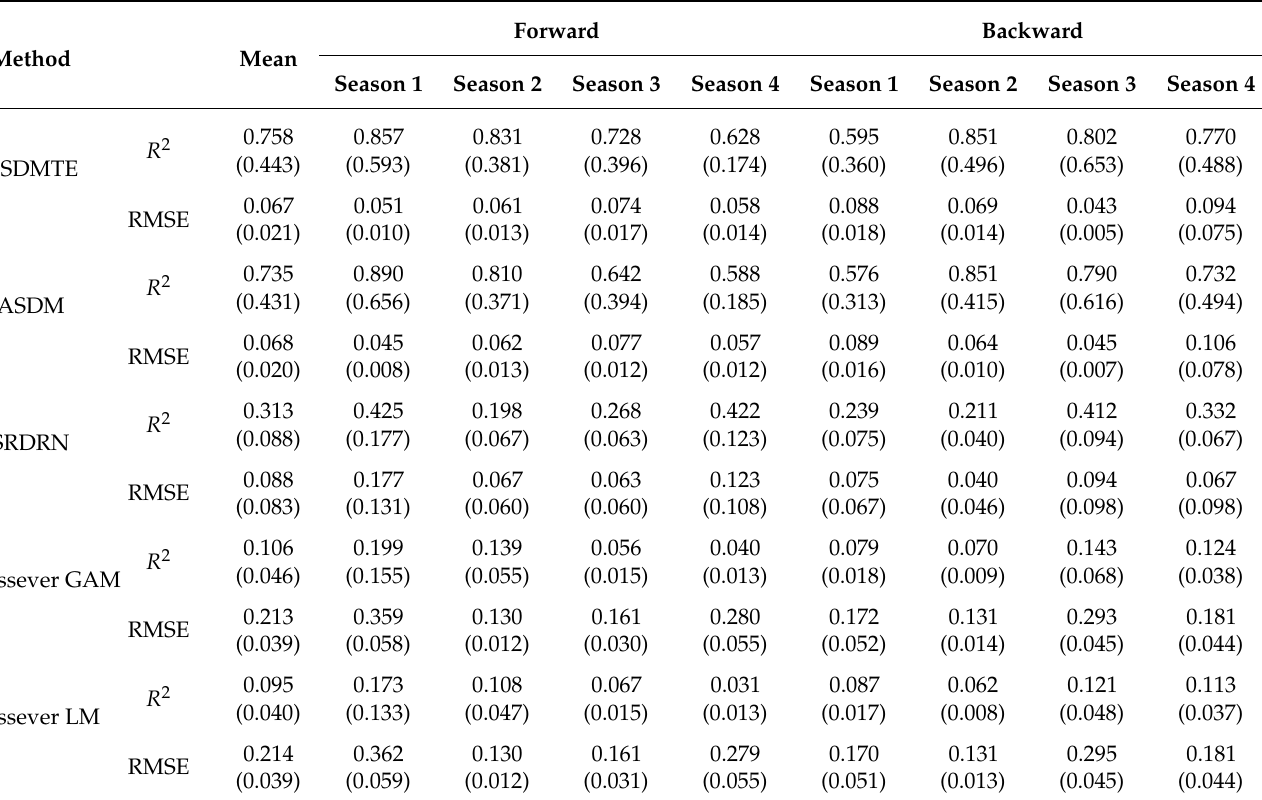
Table 1. Image-wise R 2 and RMSE from downscaling (by method); R 2 is presented as Max (Mean), and RMSE is presented as Mean